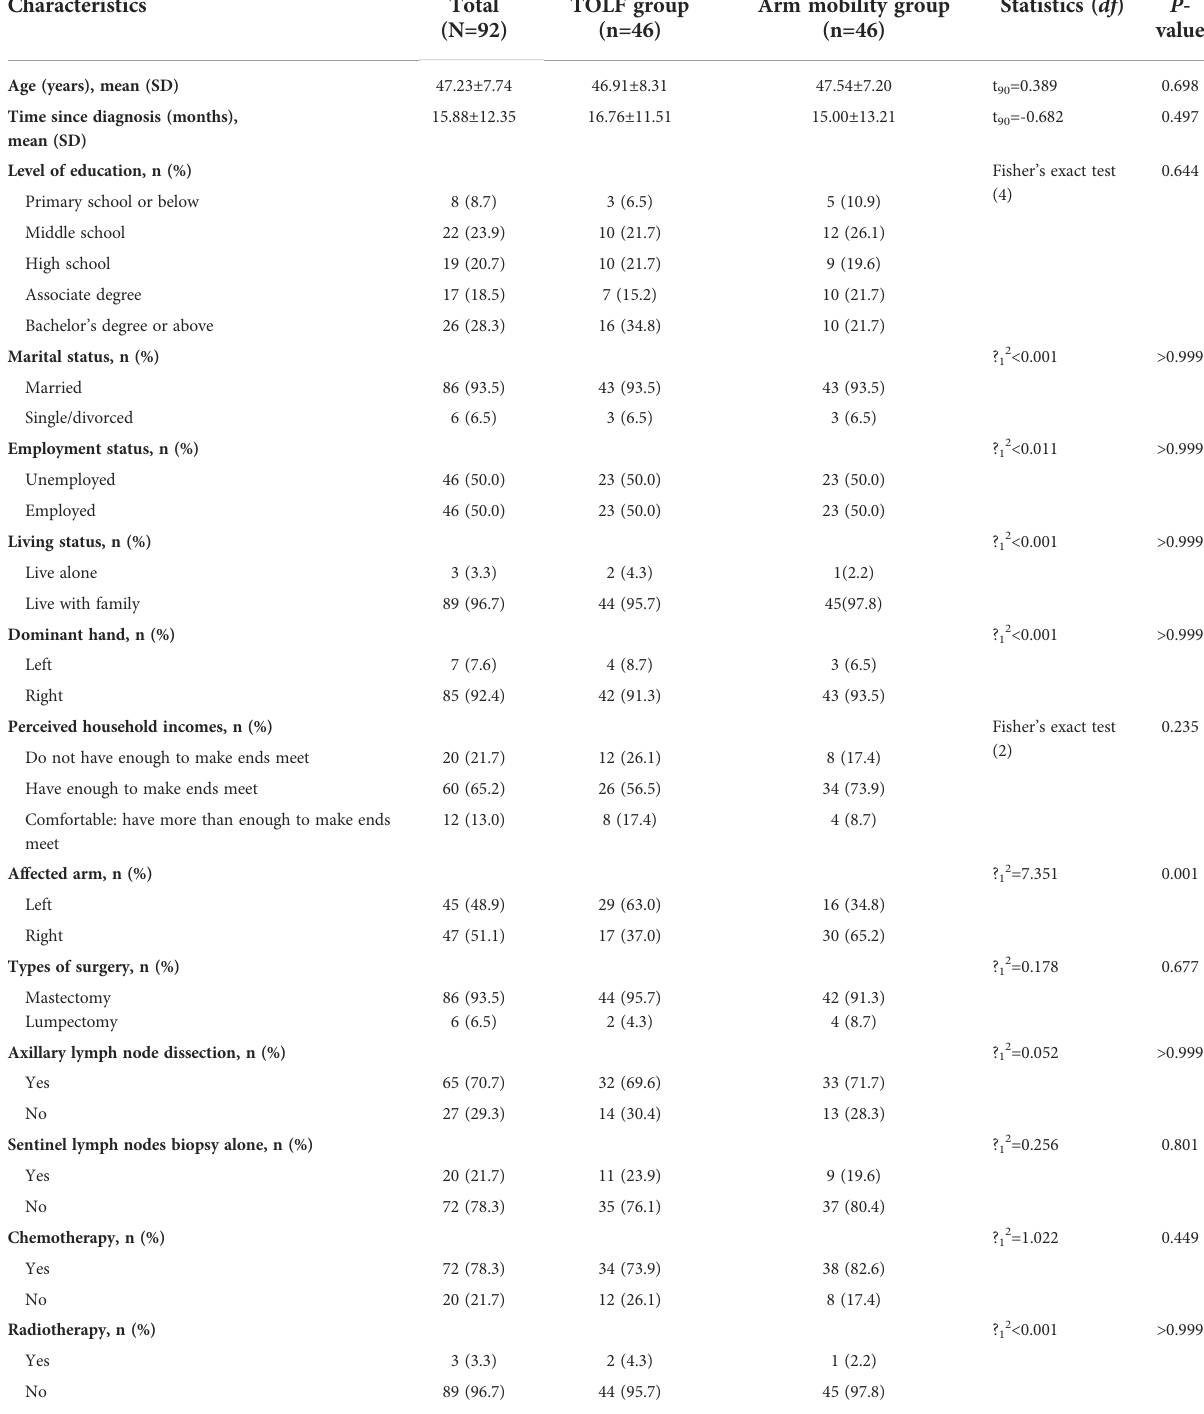
TABLE 2 Demographic and clinical characteristics of participants at baseline